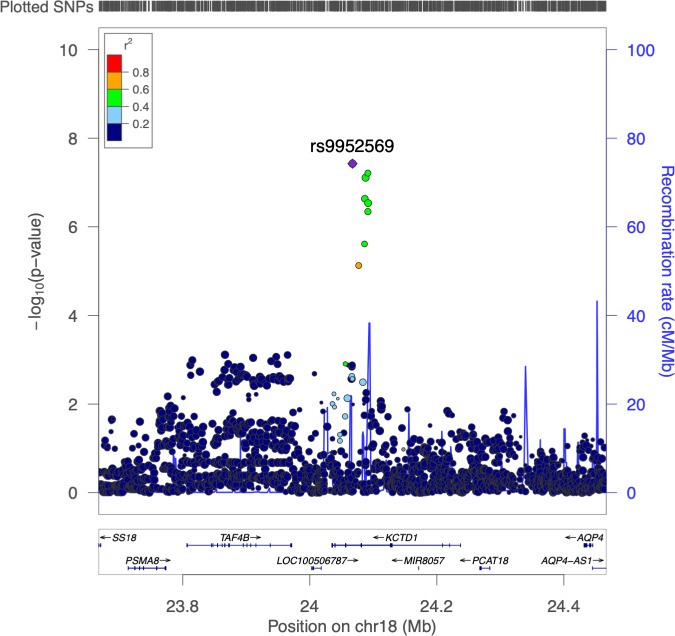
Regional association plot for rs9952569.